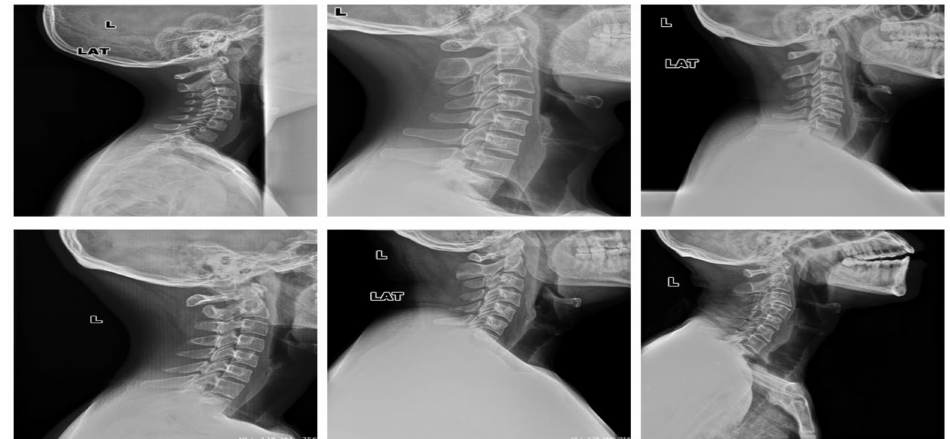
Figure 8. Samples from the third group (CS normal